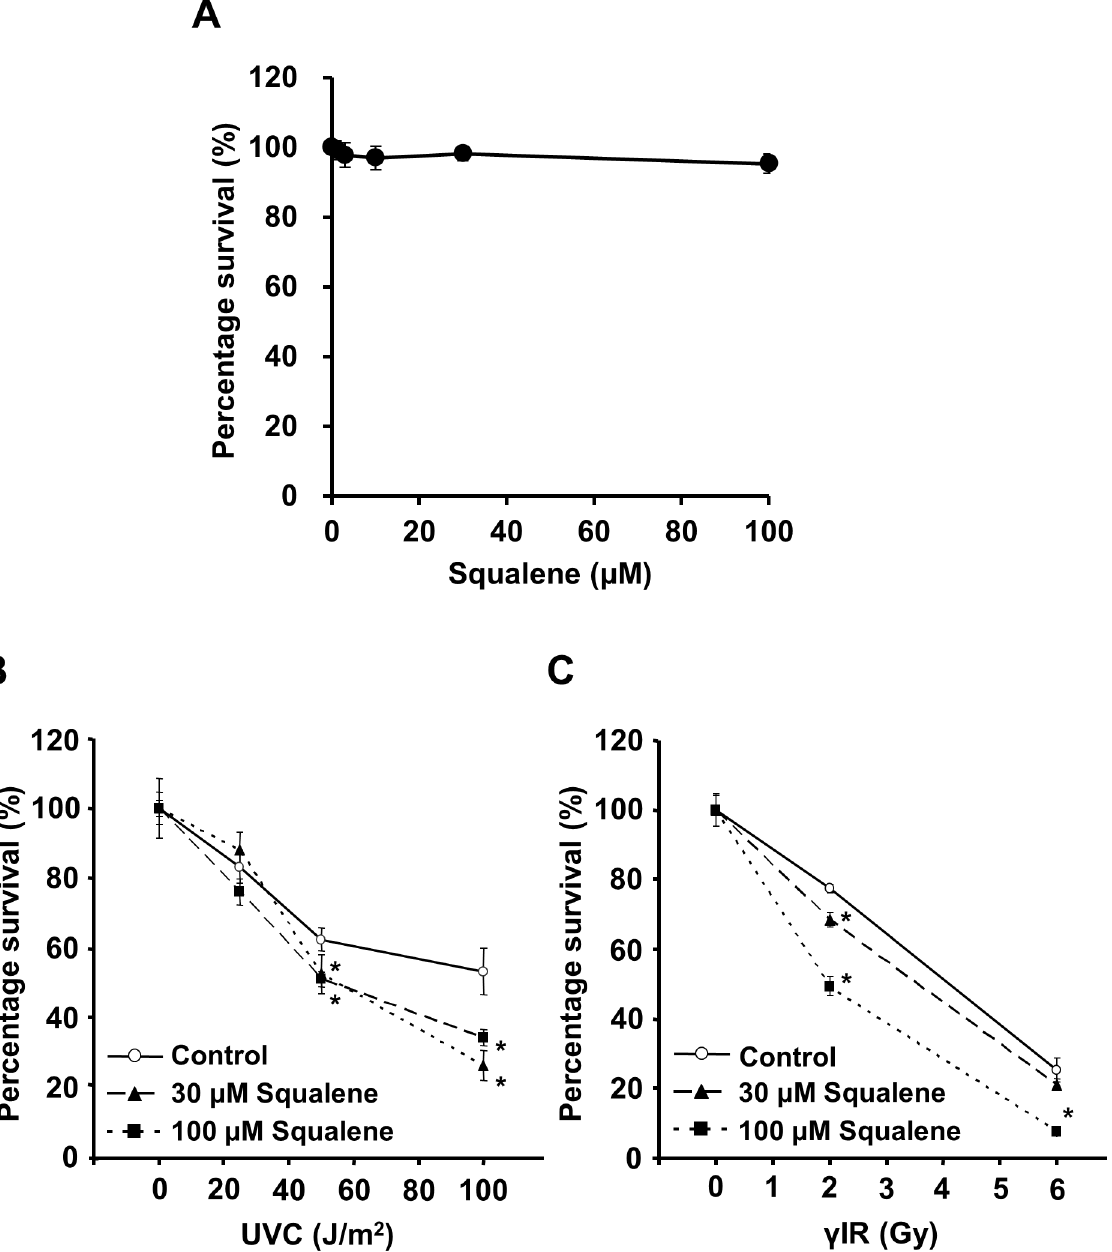
Fig 2. Squalene enhances γ IR toxicity. Relative cell viability was measured by a clonogenic assay. (A) Cytotoxicity of squalene (0, 1, 3, 10, 30, and 100 μ M) was measured after 14 days of incubation. (B) and (C) Impact of squalene on radiation toxicity. The cells were subjected to 1 h of pre-incubation and 14 days of post-incubation with squalene (0, 30, and 100 μ M) after UVC irradiation (0, 25, 50, and 100 J/m 2 ) or γ IR (0, 2, and 6 Gy). Data are presented as the mean ± S.D. of three independent experiments ( * P < 0.05 vs. untreated